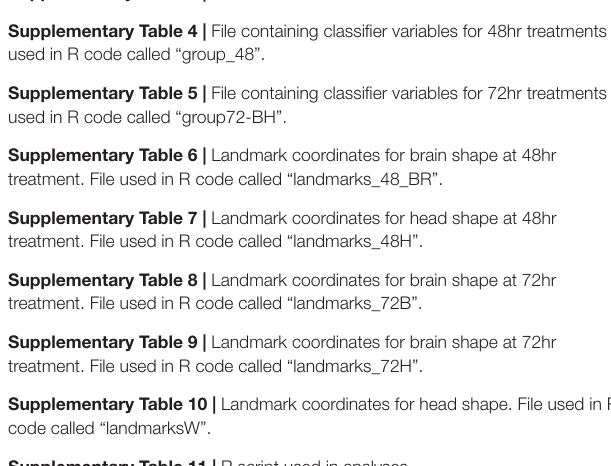
Supplementary Figure 1 | Experimental procedure and validation of Wnt3a overexpression. (A) Picture of a St10 chicken indicating the sites of RCAS injection (red arrows). (B) Whole mount in situ hybridization for v-ENV. (C) In situ hybridization in section for v-ENV in red showing that the RCAS infection is mesenchyme specific, blue nuclear staining. (D) Boxplot representing differences -delta CT for WNT3A , AXIN2 , and GAG expression. Supplementary Figure 2 | Ectopic expression of Wnt3a affects Shh expression but not FGF8 and apoptosis. (A) Whole embryo in situ hybridization for FGF8 . (B) In situ hybridization for Shh in head section. (C) TUNEL assay in head section in green cell death in blue nuclear staining. Supplementary Figure 3 | Landmarks used to quantify shape of the head. Surface render of the head in gray and 21 landmarks in yellow in anterior (A) , lateral (B) , and dorsal (C) view. Supplementary Figure 4 | Landmarks used to quantify shape of the brain. Surface render of the brain in purple and 17 landmarks in yellow (forebrain) and red (mid-hindbrain) in ventral (A) , dorsal (B) , lateral (C) , and posterior oblique (D) view. Supplementary Figure 5 | Comparison of centroid size across experiments. (A) Centroid size of chicken head at HH22 used for the FEZ analysis. (B) Centroid size of the brain of chickens at HH18 based on 17 landmarks. (C) Centroid size of the head of chickens at HH18 based on 21 landmarks. (D) Centroid size of the brain of chickens at HH22 based on 17 landmarks. (E) Centroid size of the head of chickens at HH22 based on 21 landmarks. Supplementary Table 1 | qPCR data of GAPDH , WNT3A , AXIN2 , and GAG expression in wild-types and RCAS-Wnt3a. Supplementary Table 2 | Quantification of total cells and PHH3 positive cells in mesenchyme and neural ectoderm in sections. Supplementary Table 3 | Raw data of FEZ variables.